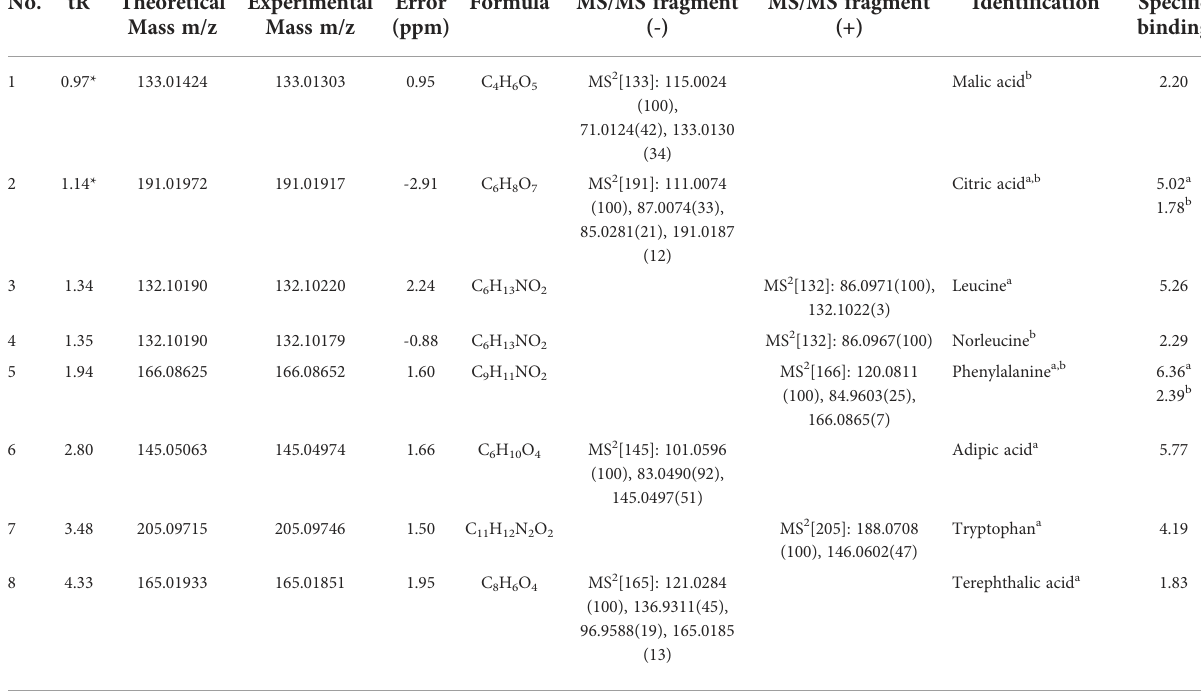
TABLE 1 AUF-LC-MS data for possible ER a /ER b ligands in Arnebiae Radix .